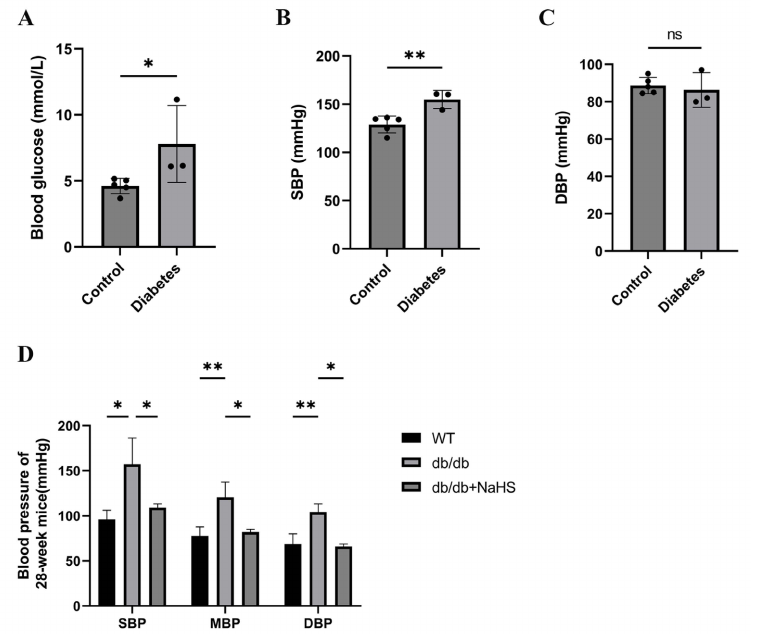
Figure 1. Blood pressure was measured in patients with diabetes and db/db mice. ( A – C ) Blood glucose, SBP and DBP of normoglycemic patients and patients with diabetes and hypertension ( n = 3–5). ( D ) SBP, MBP and DBP in 28-week db/db mice ( n = 4). * p < 0.05, ** p < 0.01. SBP, systolic blood pressure. MBP, mean blood pressure. DBP, diastolic blood